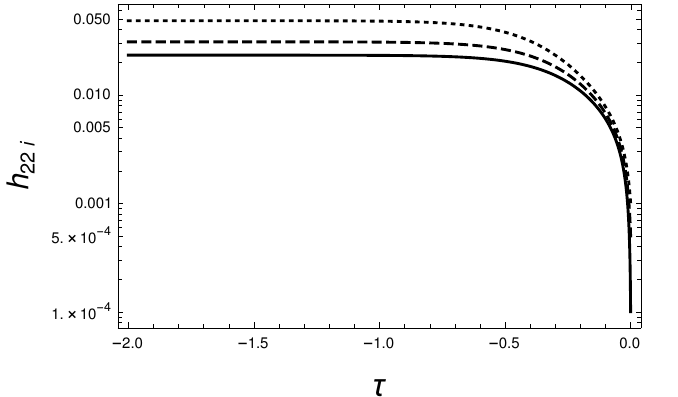
Figure 9. Scaling of the open parameters at g 2 ( Λ ) = 0.2 − i 0.002, g 4 ( Λ ) = 0.1, h 11 ( Λ ) = − i 2 g 2 i , h 22 ( Λ ) = i 0.0001 (solid line), h 22 ( Λ ) = i 0.0005 (dashed line), h 22 ( Λ ) = i 0.001 (dotted line), η =